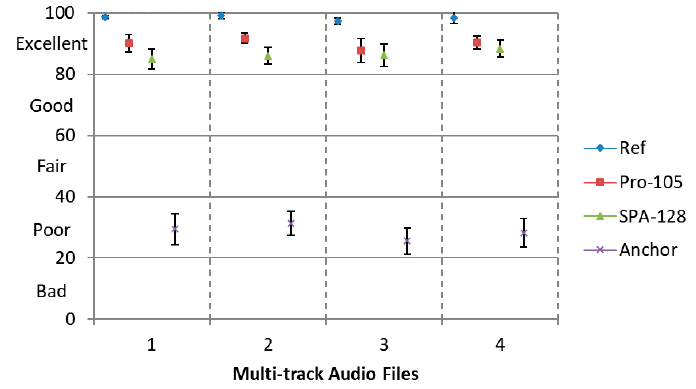
Figure 7. MUSHRA test results for the SPA method encoding at 128 kbps and the proposed approach at 105.14 kbps with 95% confidence intervals.